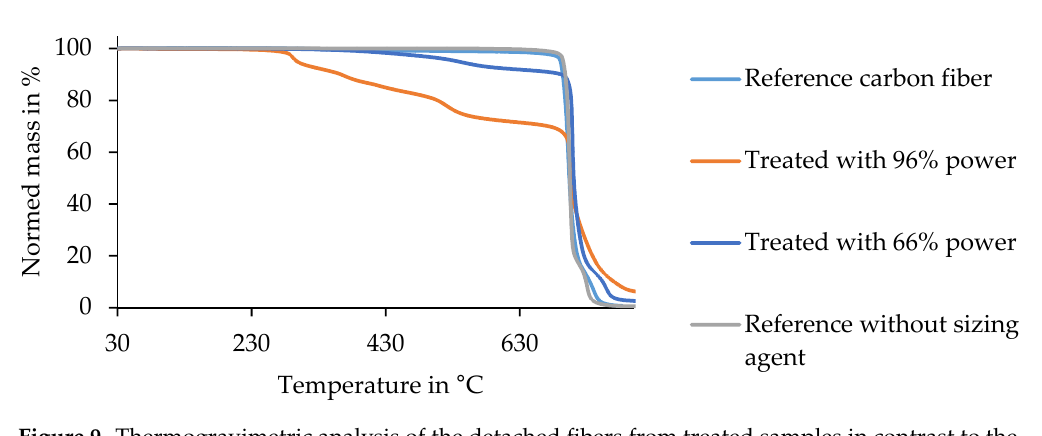
Figure 9. Thermogravimetric analysis of the detached fibers from treated samples in contrast to the fiber reference.